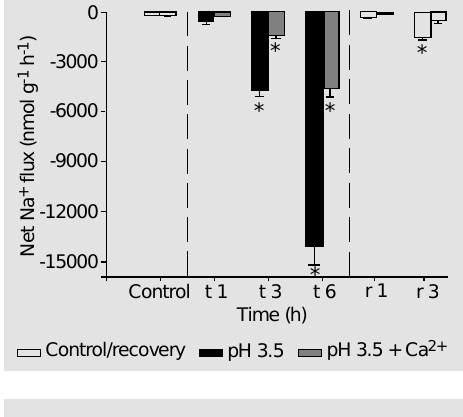
Figure 2. Net Na + flux of Corydo- ras schwartzi exposed to pH 3.5 and pH 3.5 plus Ca 2+ . Values are reported as means ± SEM (N = 10). *P (cid:1) 0.05 compared (cid:0) to a con- trol measurement performed at pH 6.0 (Dunnett test). Water was changed to circumneutral pH for recovery (r) after 6 h of treat- ment